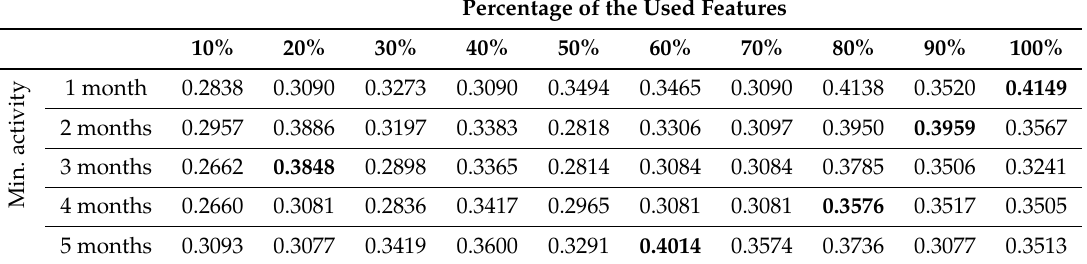
Table A8. F-score macro average for the Neural Network classification of three levels of the hierarchy in the manufacturing company dataset. The values which are bolded are the best results for a given minimum communication activity.